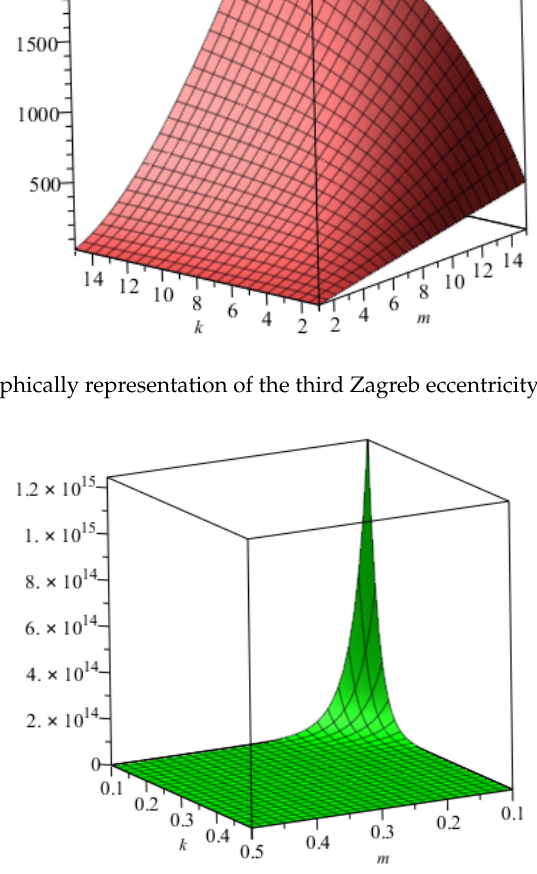
Figure 7. The graphically representation of the geometric-arithmetic index GA 4 ( OX n )